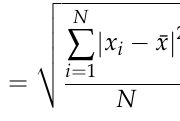
Figure 4. Exemplary representation of features extracted from an sEMG data signal segmented based on three different segment lengths (blue: T = 0.15 s, orange: T = 0.225 s and green: T = 0.3 s; purple: no segmentation), as well as the corresponding elbow-joint angle θ (red), recorded experimentally. The features depicted were extracted from segments with no offset δ and an overlap corresponding to a sample frequency of 100 Hz. Shown are the following features: ( a ) activation dynamics ( ACT ), ( b ) root mean square ( RMS ), ( c ) mean absolute value ( MAV ), ( d ) waveform length ( WL ), ( e ) standard deviation ( SD ), ( f ) variance ( VAR ), ( g ) signal slope change ( SSC ), ( h ) zero crossings ( ZC ), ( i ) Willison amplitude ( WAMP ), ( j ) integrated EMG ( iEMG ), and ( k ) mean of signal frequencies ( MNF ). The SD feature (i.e., the standard deviation of an input signal; Figure